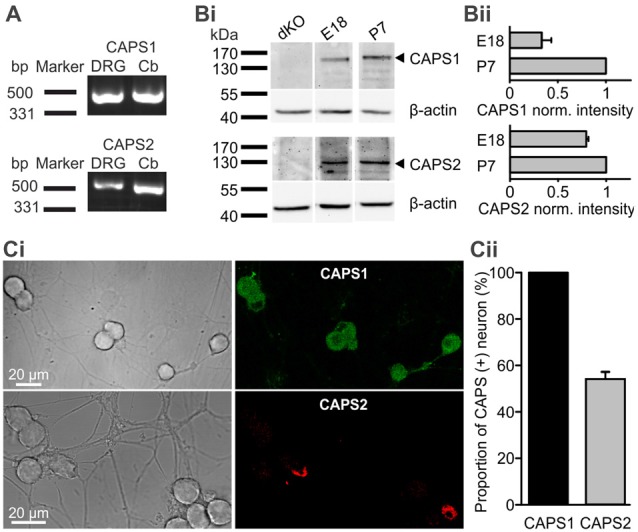
All dorsal root ganglion (DRG) neurons express calcium-dependent activator protein for secretion 1 (CAPS1) while only 50% express CAPS2. (A) CAPS1 and, to a lesser extent, CAPS2 mRNA was detected in DRGs. Total RNA from the DRGs (five adult mice) and cerebellum as positive control was probed for CAPS1 and CAPS2 by RT-PCR. (Bi) Western blot (WB) analysis of CAPS protein expression during development. DRGs were isolated from wild-type (WT) and CAPS DKO E18, and WT P7 mice and blotted with the indicated antibodies (Table 1). Actin was used as a loading control. (Bii) Actin-based corrected protein expression levels were normalized to the P7 signal (n = 2). (Ci) Immunocytochemistry of DRG neurons in culture with anti-CAPS1 (top) and anti-CAPS2 (bottom) antibody suggests that CAPS1 is present in all DRG neurons while CAPS2 is present in a subpopulation of DRG neurons. The specificity of the antibodies was verified (Supplementary Figure S5). (Cii) Quantification of CAPS paralog expression among DRG neurons (Nmice = 5, nneuron = 70 and 191 for CAPS1 and CAPS2, respectively).